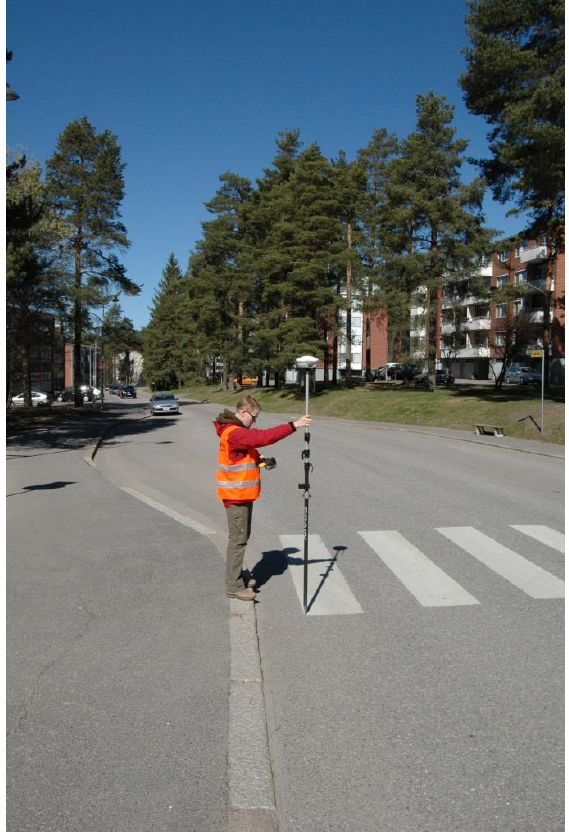
Figure 4. Reference point measurements using a Trimble R8 VRS-GNSS